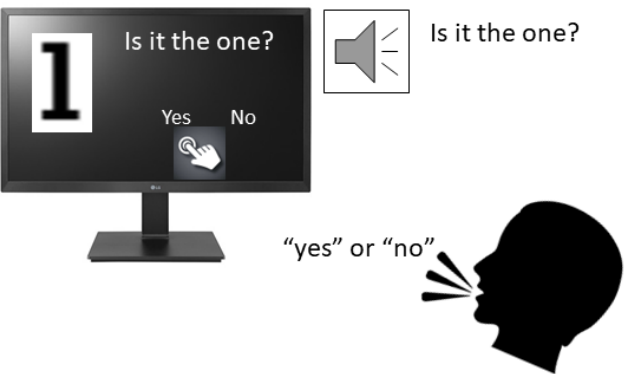
Figure A7. Interaction between the preschool children and the recognition system for the confirma- tion of answers.